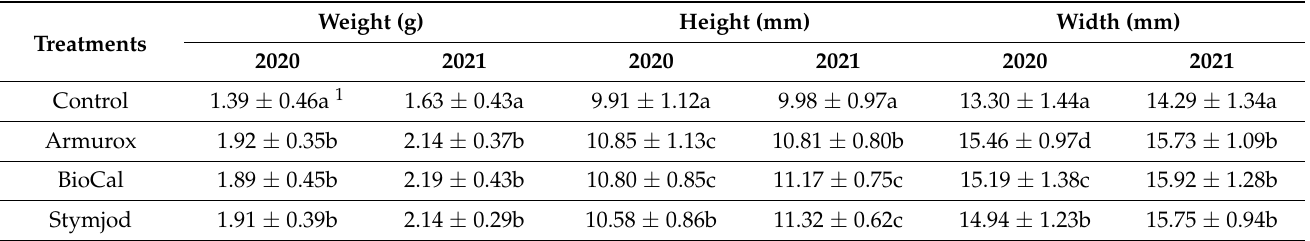
Table 5. Effect of foliar fertilization on highbush blueberry fruit weight and biometric parameters in